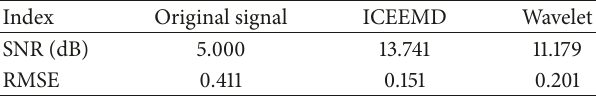
Table 1: ICEEMD denoising performance